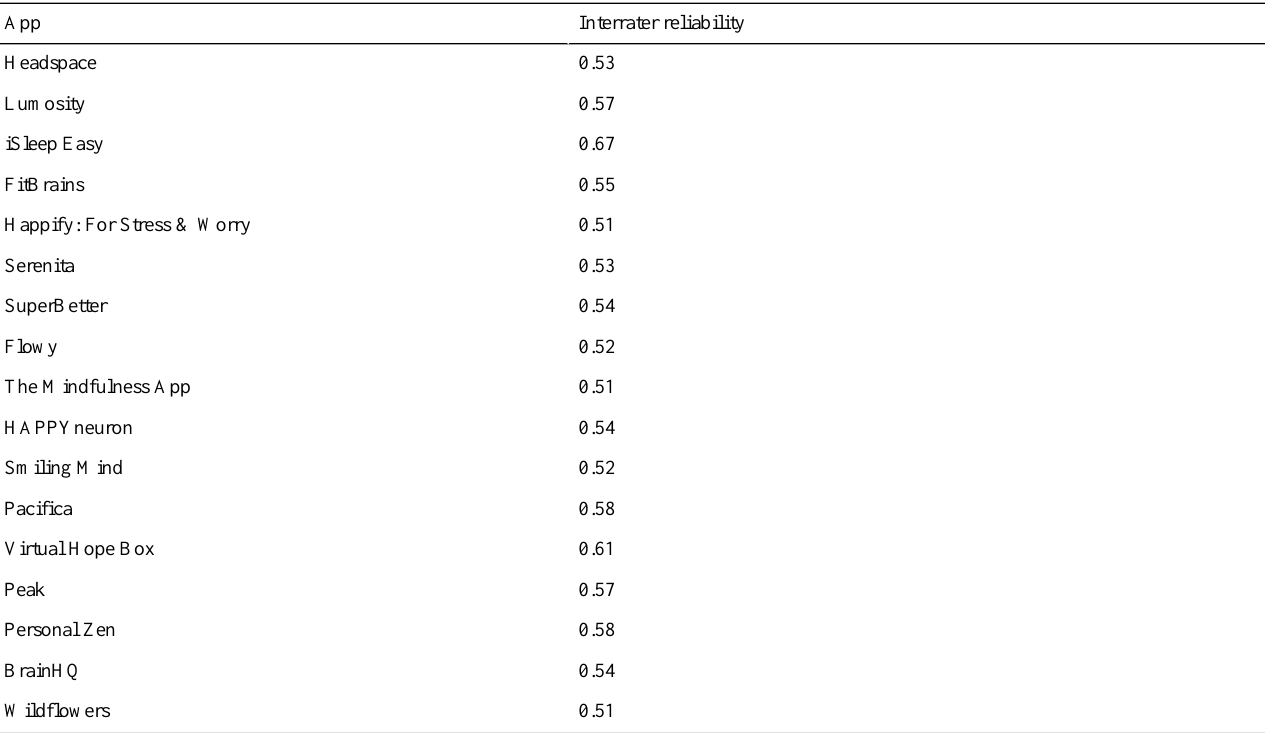
Table 3. Interrater reliability scores for each